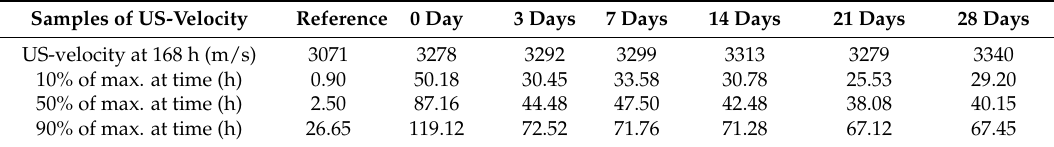
Table 2. The maximum of the US-velocity at 168 h of the reference (without retarder) and the reactivated mixtures with Ac2 and the points in time when 10%, 50% and 90% of the maximum US-velocity were